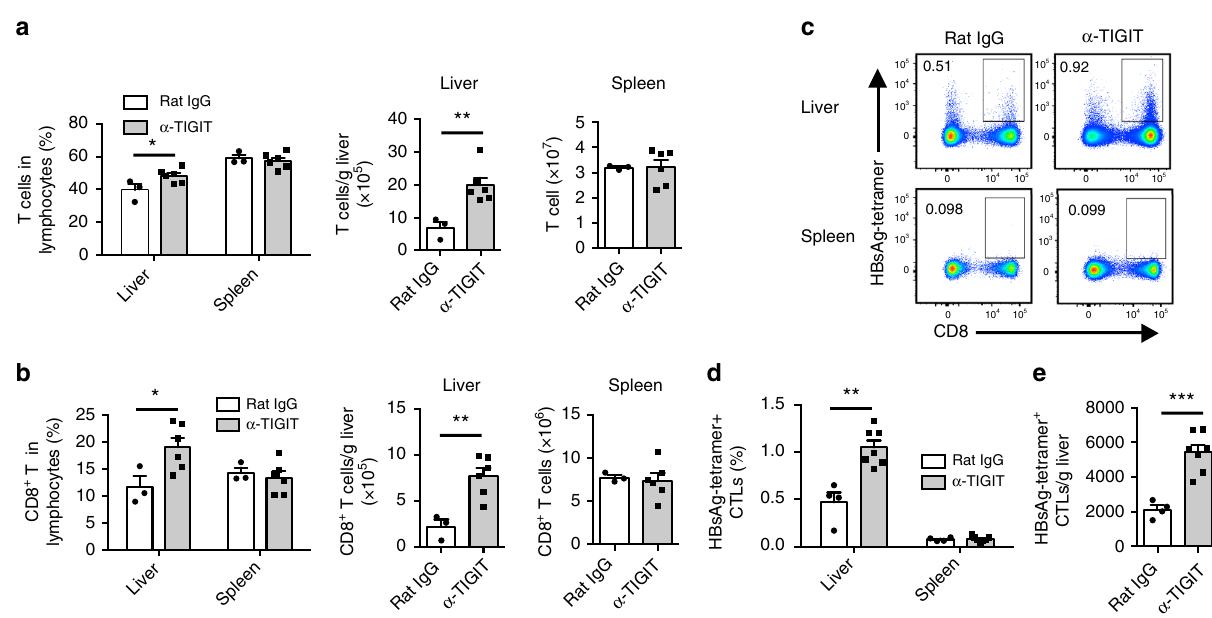
Fig. 5 HBsAg-speci fi c CD8 + T cells dramatically increase after TIGIT blockade in the liver. a – e HBs-tg mice were treated with rat IgG or α -TIGIT mAb for 3 months. a , b The percentage and absolute number of total T cells ( a ) and CD8 + T ( b ) cells in the liver and spleen of rat IgG or α -TIGIT-treated HBs-tg mice ( n = 3, 6; Rat IgG, α -TIGIT). c Representative fl ow cytometric graphs showing HBsAg-speci fi c CTLs in the liver and spleen of rat IgG or α -TIGIT- treated HBs-tg mice. d The statistical percentages in ( c ) are shown ( n = 4, 7; Rat IgG, α -TIGIT). e The absolute numbers of liver HBsAg-speci fi c CTLs are shown ( n = 4, 7; Rat IgG, α -TIGIT). Statistically signi fi cant differences between the groups are presented as the mean ± SEM. * P < 0.05; ** P < 0.01; and *** P < 0.001 (two-tailed unpaired Student ’ s t -test). Data are representative of three independent